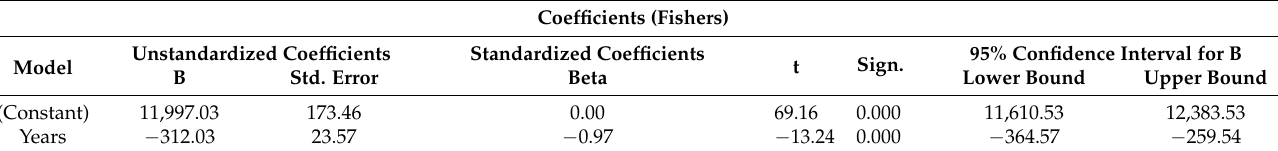
Table 6. The regression coefficients of the fishers’ linear model